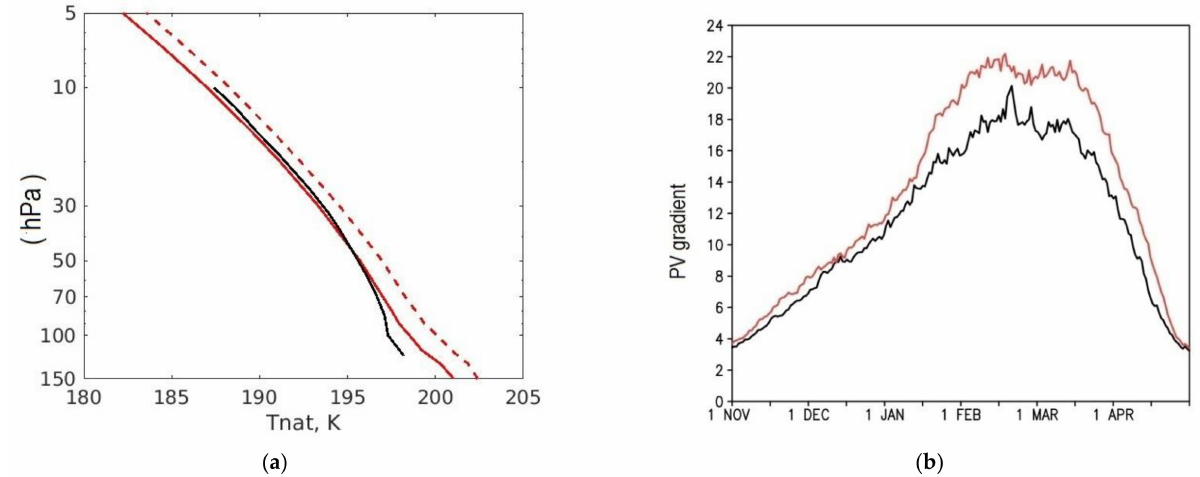
Figure 5. Profile of the critical temperature of PSC type I formation—Tnat: data from [38] (black line), data from simulation with CCM SOCOL3 for HNO 3 and H 2 O concentrations in the Arctic stratosphere averaged over 2000–2029 (red line) and over 2070–2099 (red dotted line) ( a ). Seasonal cycle of maximal meridional gradient of potential vorticity (10 − 6 s − 1 deg − 1 ) at isentropic level 600 K (~30 hPa) in the severe scenario averaged over 2015–2044 (black line) and 2070–2099 (red line) ( b